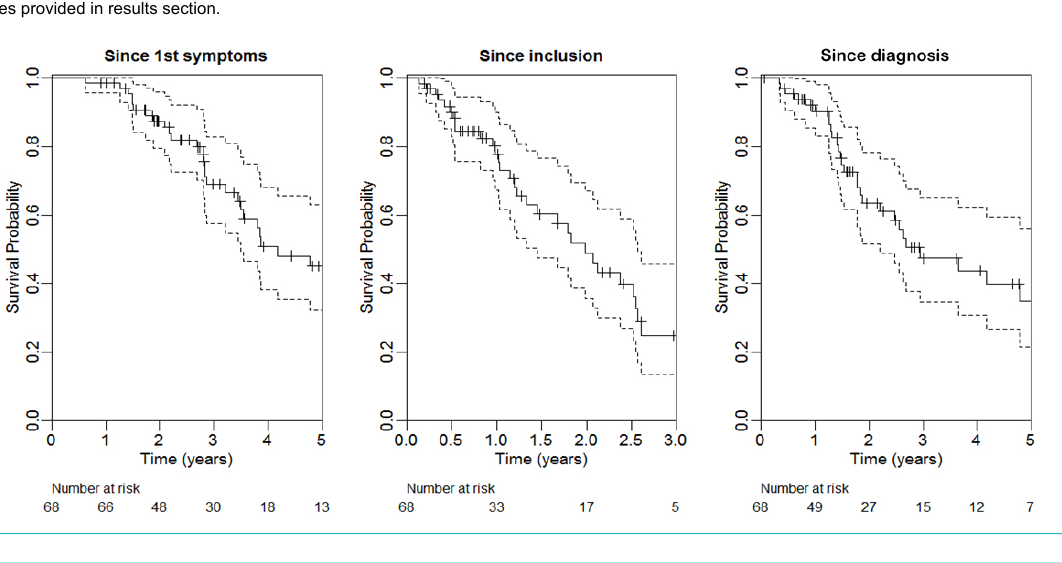
Figure 3: Overall survival from first ALS symptoms, inclusion and diagnosis (Kaplan Meier curves with 95% CI); n = 68 subjects. Median val- ues provided in results section.